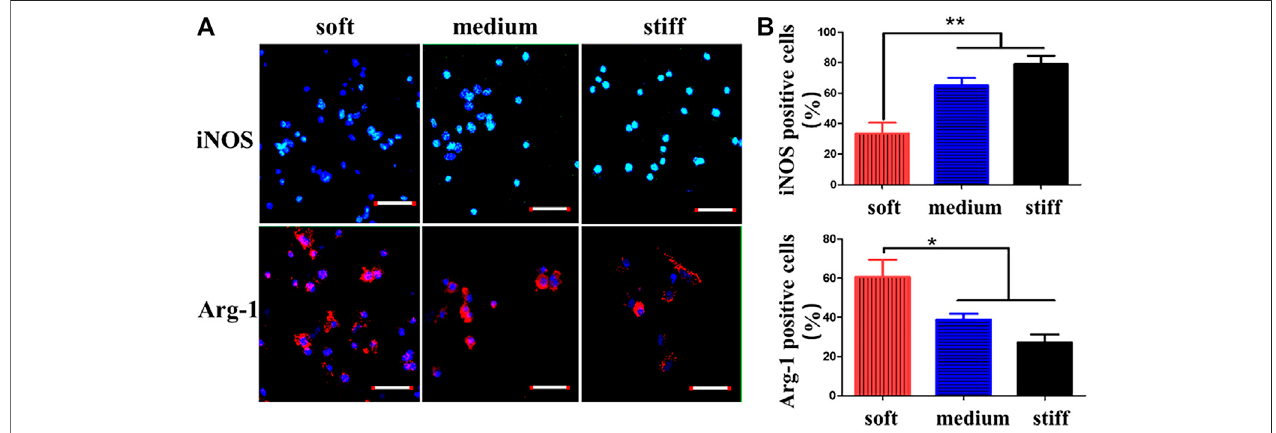
FIGURE 6 | CD marker expression of macrophages on GelMA hydrogels of different stiffnesses. (A) Macrophages of GelMA hydrogels of different stiffnesses stained with iNOS (M1 marker) and Arg-1 (M2 marker). (B) Percentages of iNOS- and Arg-1-positive macrophages quanti fi ed after 3 days of macrophage